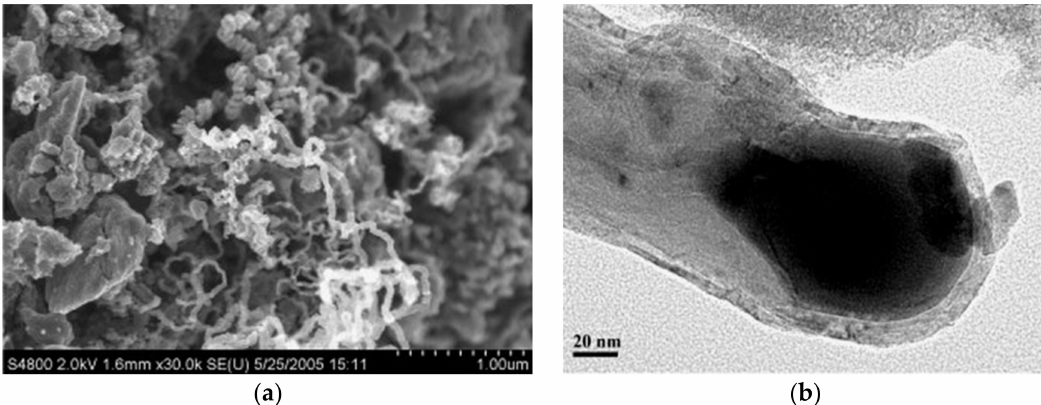
Figure 13. ( a ) SEM image of carbon nanofibers supported on biochar; ( b ) TEM image of a carbon nanofiber with an Fe particle on the tip. Reprinted with permission from Reference [169]. Copyright (2008) Elsevier Ltd.